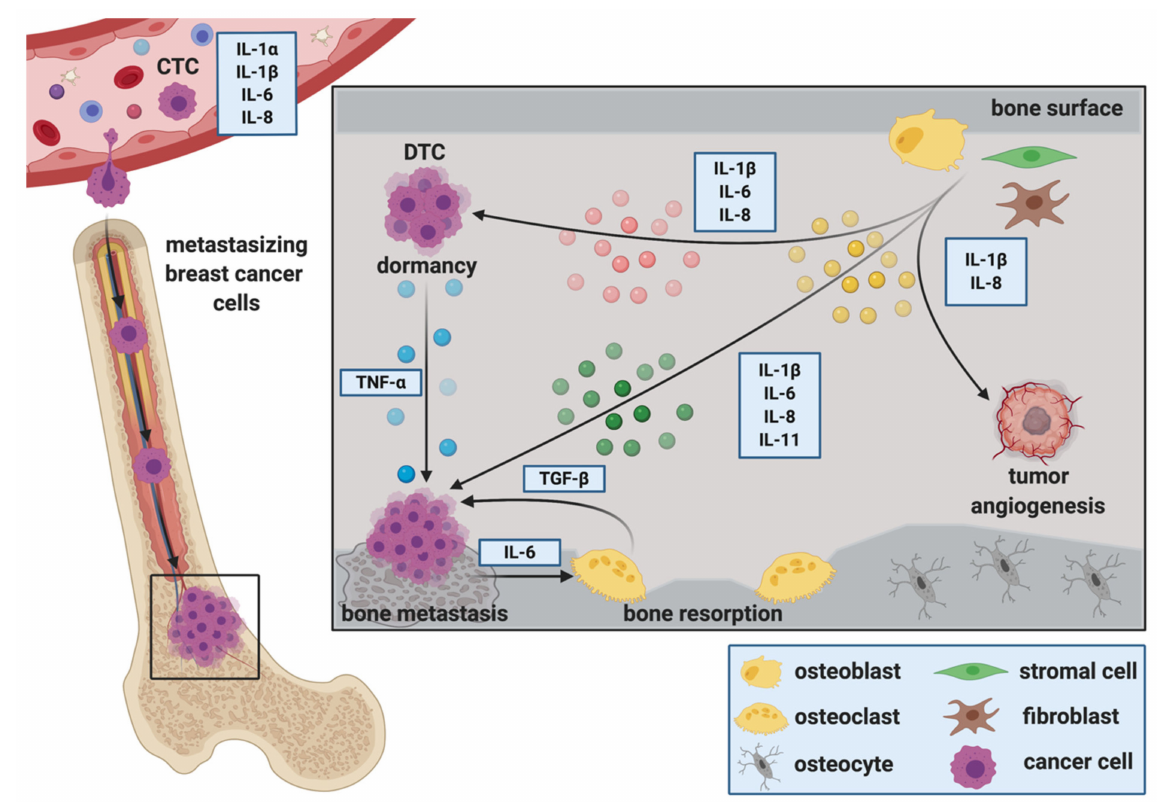
Figure 1. Interleukins during the progression of breast cancer bone metastasis. Interleukins (ILs) play pivotal roles in mediating several steps of the metastatic cascade in breast cancer. Dynamic changes in circulating tumor cell (CTC) levels in combination with corresponding alterations in serum IL levels might serve as prognostic markers for the progression of breast cancer. Furthermore, ILs are suggested to regulate the attraction of disseminated tumor cells (DTCs) to the metastatic site, facilitate extravasation from the circulation, adhesion and migration in the secondary organ. Once in the secondary organ, DTCs receive interleukin signals from adjacent, tissue-resident cells that regulate their fate in the secondary organ. Cells of the bone microenvironment secrete ILs that control tumor cell dormancy. In turn, proliferating tumor cells secrete ILs that stimulate osteoclastic bone resorption and consequently osteolysis. Factors released during osteolysis (e.g., Transforming growth factor β (TGF- β )) then fuel the vicious cycle of bone metastasis. Stromal-derived ILs can also regulate tumor growth via affecting vascular endothelial cells, thus promoting vascularization and metastatic